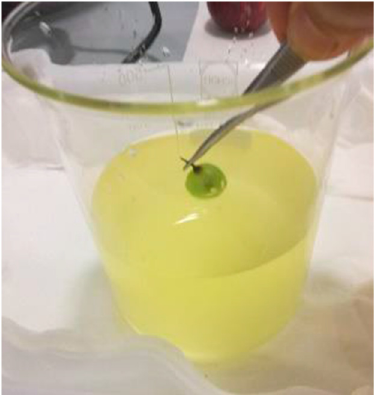
Figure 1. Biosurfactant extract solution for the coating treatment of